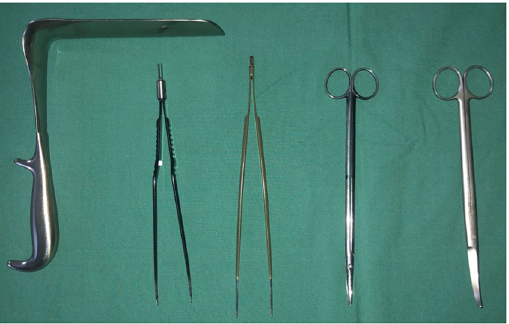
Figure 4. A set of special long surgical instruments: long retractor, bipolar diathermy forceps, tweezers, straight and curved